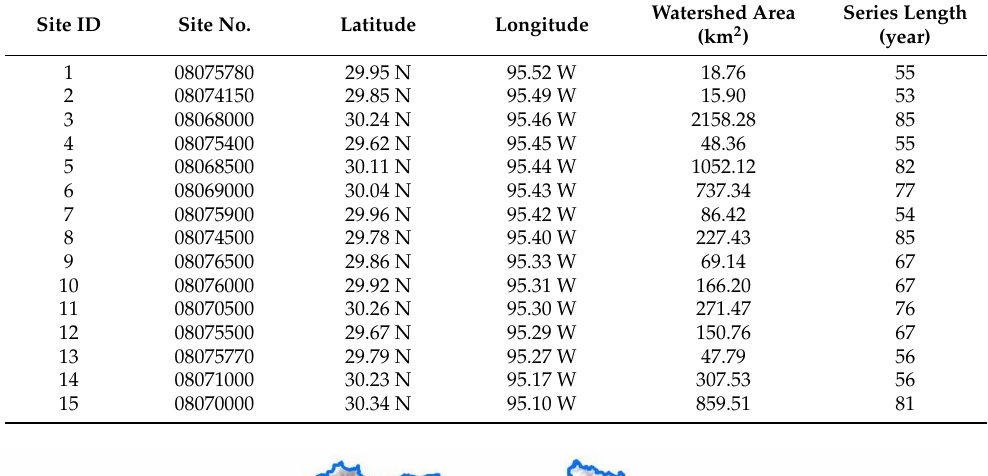
Table 1. Summary of the 15 watersheds with more than 50 records.